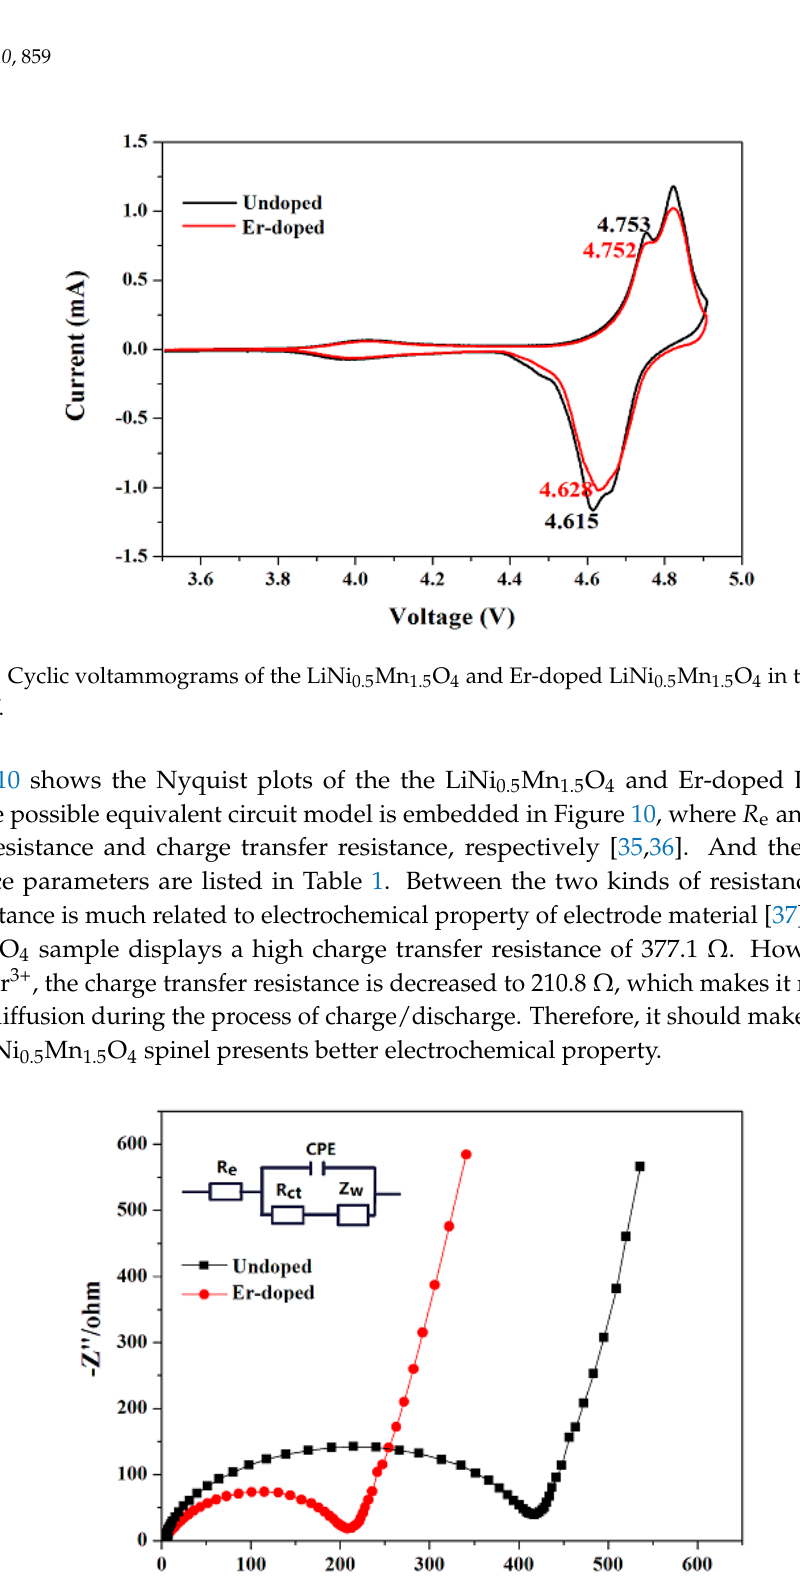
Figure 8. Representative discharge curves of the LiNi 0.5 Mn 1.5 O 4 ( a ) and Er-doped LiNi 0.5 Mn 1.5 O 4 ( b )